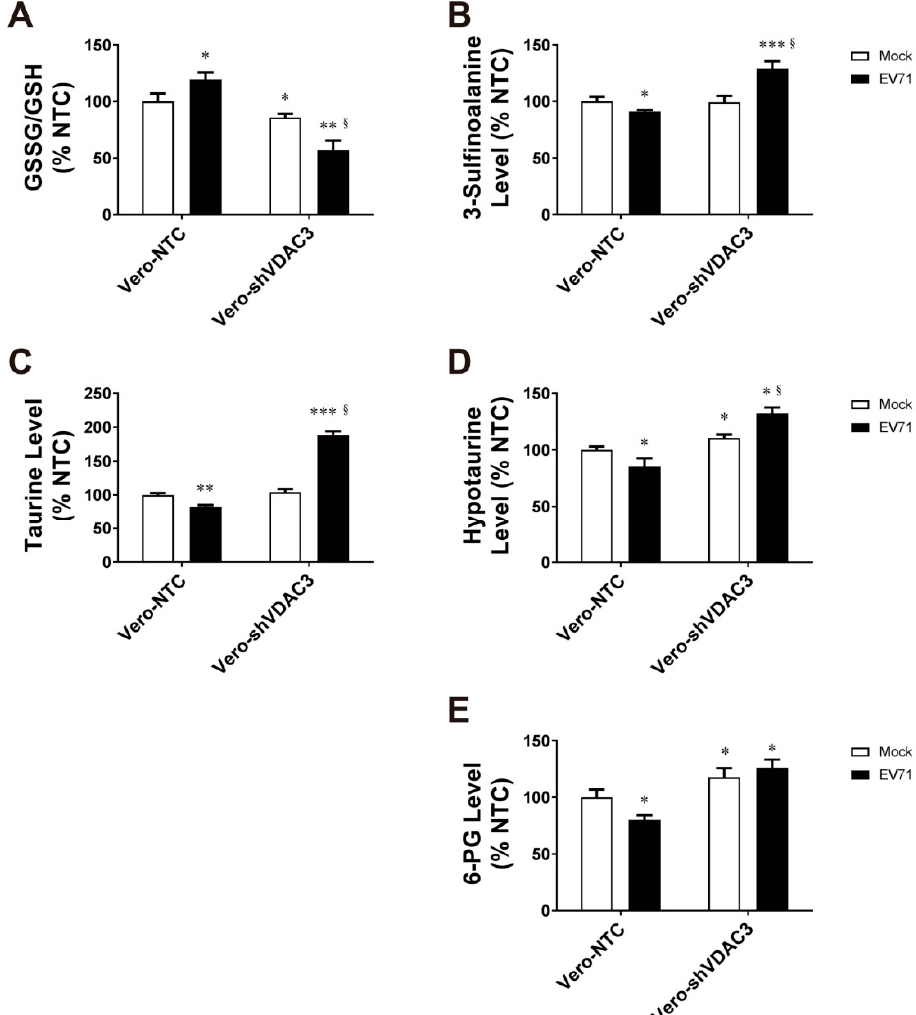
Figure 8. Alterations in antioxidant metabolism in EV71-infected cells. Vero-NTC and Vero-shVDAC3 cells were mock infected ( Mock ) or infected ( EV71 ) at an MOI of 1.25, and extracted at 16 h post- infection for metabolomic analysis with UPLC-Q-TOF-MS ( n = 18). Their GSSG/GSH ratio ( A ) and intracellular levels of 3-sulfinoalanine ( B ), taurine ( C ), hypotaurine ( D ) and 6-PG ( E ) are shown. The GSSG/GSH ratio and the levels of metabolites are expressed as a percentage of those of the mock ‐ infected Vero ‐ NTC cells. Data are mean ± SD ( n = 18). * p < 0.05, ** p <0.01, *** p < 0.005, vs. mock ‐ infected Vero ‐ NTC cells; § p <0.05 vs. infected Vero ‐ NTC cells.